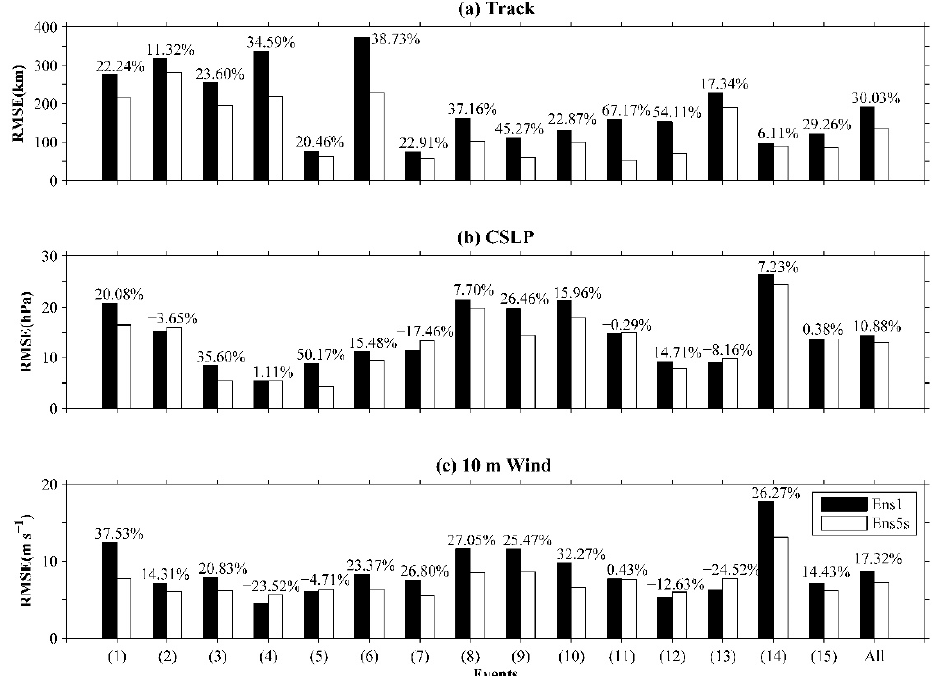
Figure 5. Improvement percentages of the RMSE of Ens5s for the ( a ) Track, ( b ) CSLP, and ( c ) 10-m wind of 15 typhoons, compared to the RMSE of Ens1.